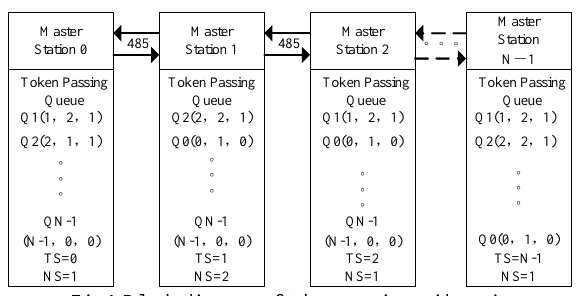
Fig.1 Block diagram of token passing